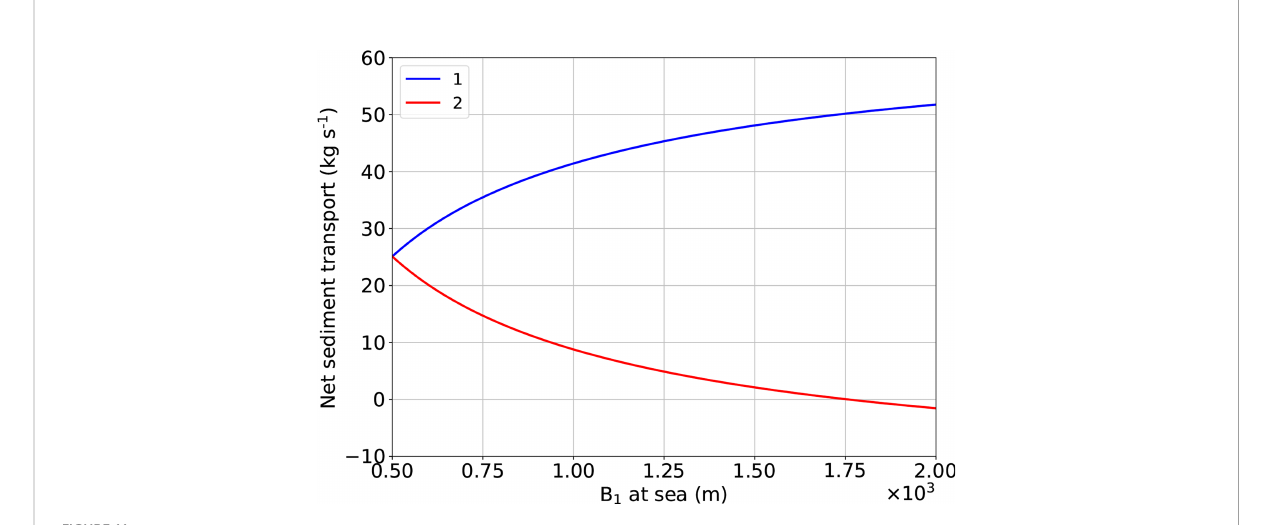
FIGURE 11 Sensitivity of net sediment transport to the width of Channel 1 at